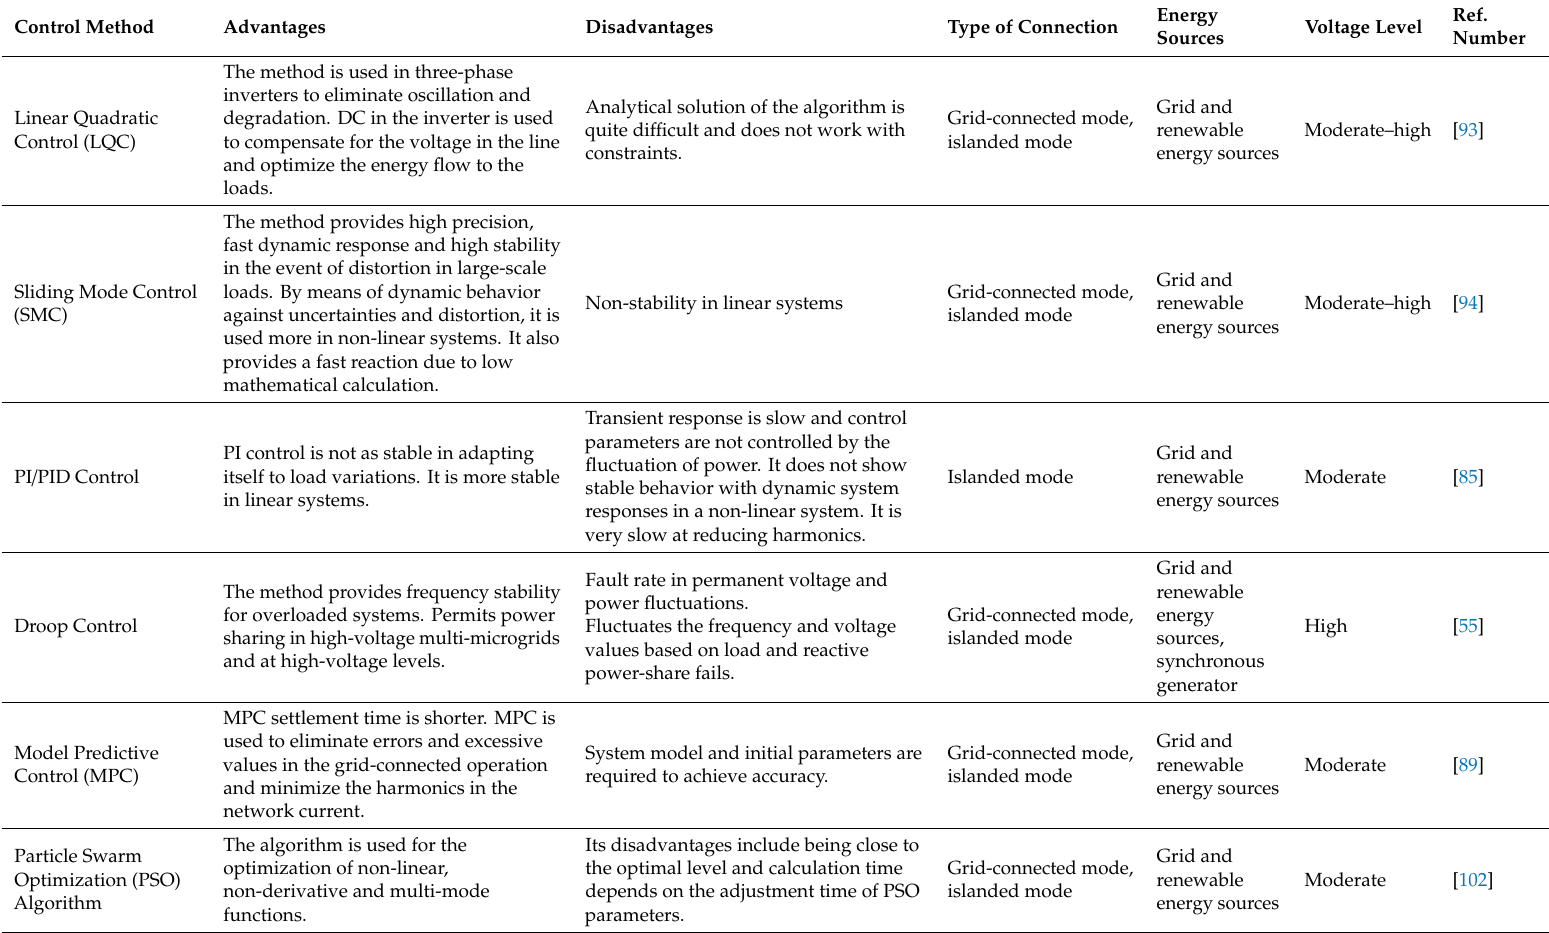
Table 2. Control methods used for transient stability in